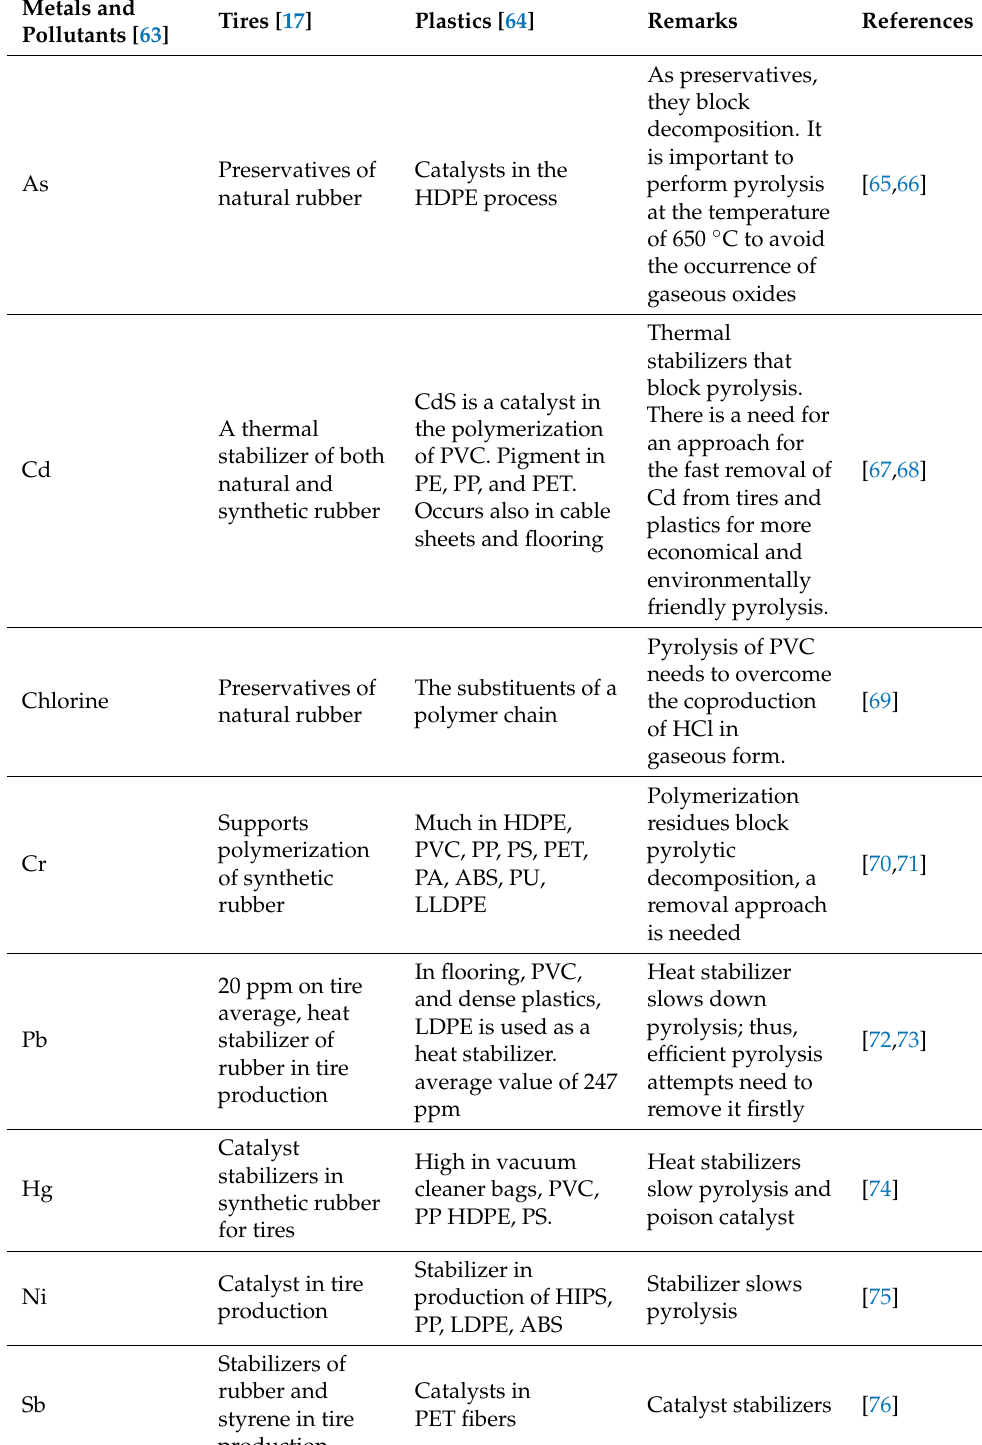
Table 3. Comparison of most common additives in tires and